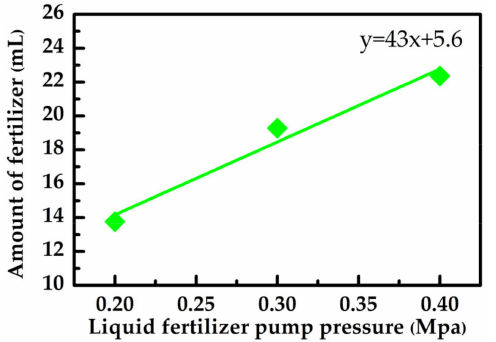
Figure 11. Influence of different hydraulic pump pressures on liquid fertilizer